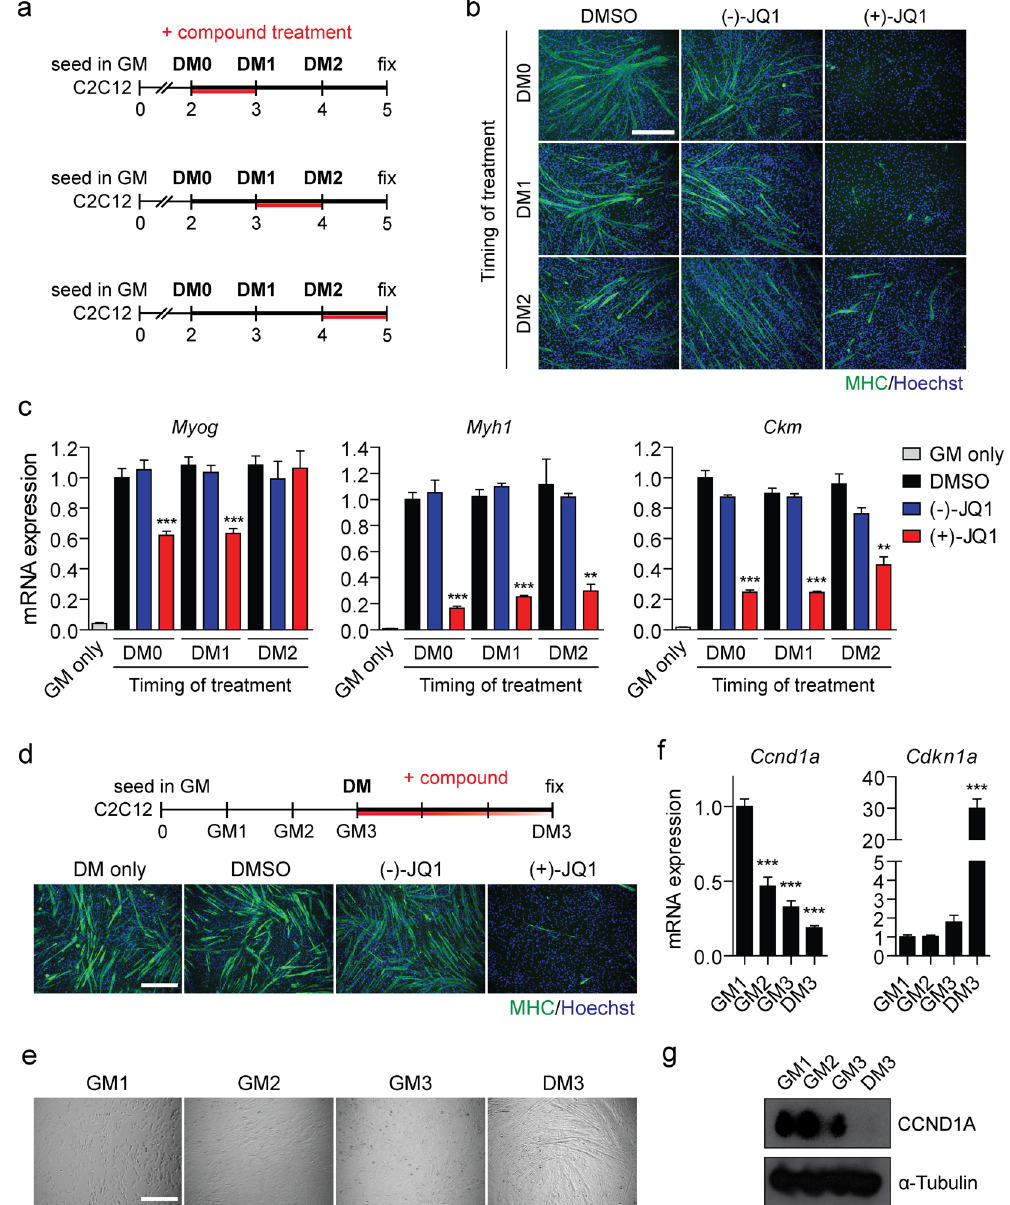
Figure 5. BETi treatment inhibits differentiation independently of cell cycle arrest. ( a ) C2C12 cells were treated with 1 µ M ( + )-JQ1 for a 24 hour interval starting at day 2, 3 or 4 (corresponding to zero, one or two days in Differentiation Media; DM0, DM1 and DM2). Fresh DM was added at each time point in order to wash out the compound treatments. ( b ) Myogenic differentiation was assessed by MHC IF staining and compared with DMSO and ( − )-JQ1-treated negative controls. ( c ) Myogenic transcript levels for Myog , Myh1 and Ckm were determined for each treatment protocol by RT-qPCR. Cells treated with GM only were included as an additional undifferentiated control. ( d ) C2C12 cells were cultured for 3 days in GM in order to reach full confluence and promote maximal cell cycle withdrawal prior to switching to DM for 3 days. Cultures were treated with 1 µ M ( + )-JQ1 concurrent with the switch to DM. Cultures treated with ( − )-JQ1, DMSO, or left untreated (DM only) served as negative controls. Cells were fixed, and myogenic differentiation was assessed by MHC IF staining. ( b ) Light microscopy images indicate that cells were fully confluent by day 2 in Growth Media (GM2). ( c ) Changes in the cell cycle markers Ccnd1a (Cyclin D1) and Cdkn1a (p21) were assessed by RT-qPCR, and ( d ) CCND1A by western blot. All microscopy images were taken at 10 × magnification, scale bars indicate 50 µ m. Blots were cropped for conciseness and clarity. All values are mean + SD, n = 3, ** P < 0.01, *** P < 0.001. The mean of the DMSO group (treated at DM0) was scaled to a value of one. Comparisons between multiple groups were tested using one-way ANOVA with Bonferroni post hoc test, and comparisons to the ( − )-JQ1 or GM1 group